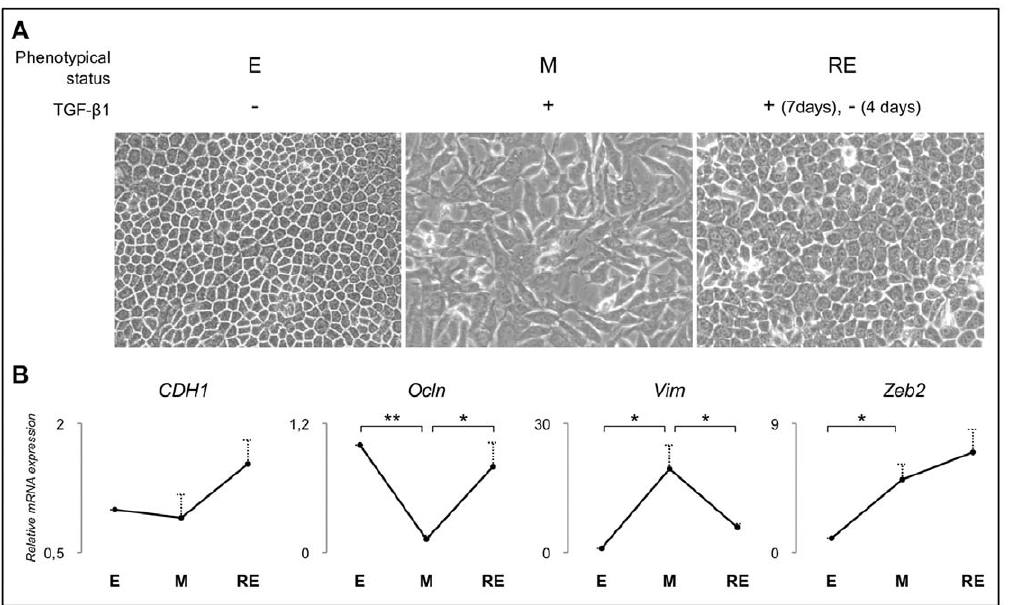
Figure 1. EMT/MET model validation. Panel A shows bright field microscopy still images of the EpH-4 cell line (400 6 ) during EMT and MET induction. E stands for epithelial cells, M stands for mesenchymal cells, and RE stands for reverted epithelial cells. E and RE cells display a cuboid shape associated with the epithelial phenotype while M cells exhibit a fibroblastic morphology associated with the mesenchymal phenotype. Panel B illustrates the quantification of CDH1 , Ocln , Vim and Zeb2 relative mRNA expression ( n =3 biological replicas). Data was normalized for results obtained for E cells. Single asterisk corresponds to p # 0.05 and double asterisks stands for p # 0.001. CDH1 expression, an epithelial marker, was not significantly altered during EMT/MET induction; Ocln expression, an epithelial marker, was significantly decreased in M cells (in comparison to E cells) and recovered in RE cells (in comparison to M cells); Vim expression, a mesenchymal marker, was significantly increased in M cells (in comparison to E cells) and decreased in RE cells (in comparison to M cells) and; Zeb2 expression, a classical EMT inducer, was significantly increased in M cells in comparison with E cells, supporting EMT occurrence.